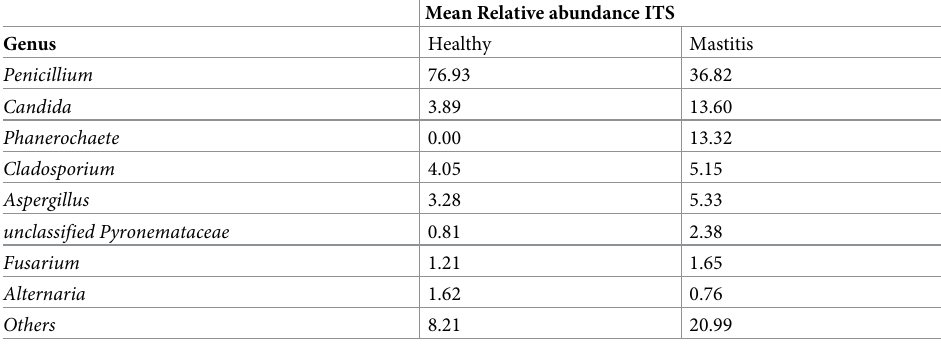
Table 5. Relative abundance of fungal population in healthy and mastitis camel milk at genus level for